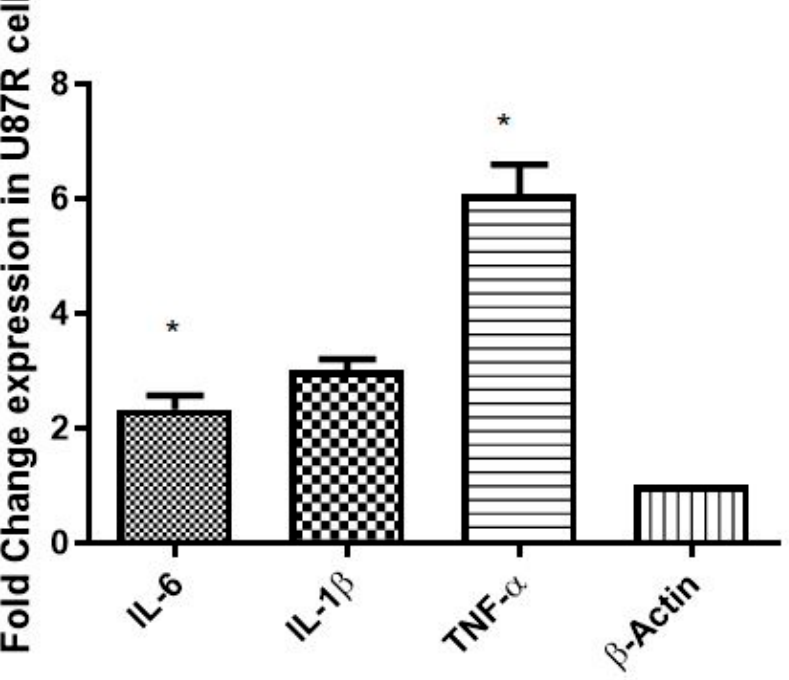
Figure 17. Fold change in gene expression of IL-6, IL-1 β , and TNF- α (inflammatory markers) in U87-S and U87-R cell lines in an in vitro analysis. Each bar shows mean ± SD values for each gene. Experiments were conducted in triplicate. The results are normalized to β -actin, a housekeeping gene, expressed as a change from their respective controls. The level of significance is * p ≤ 0.05.